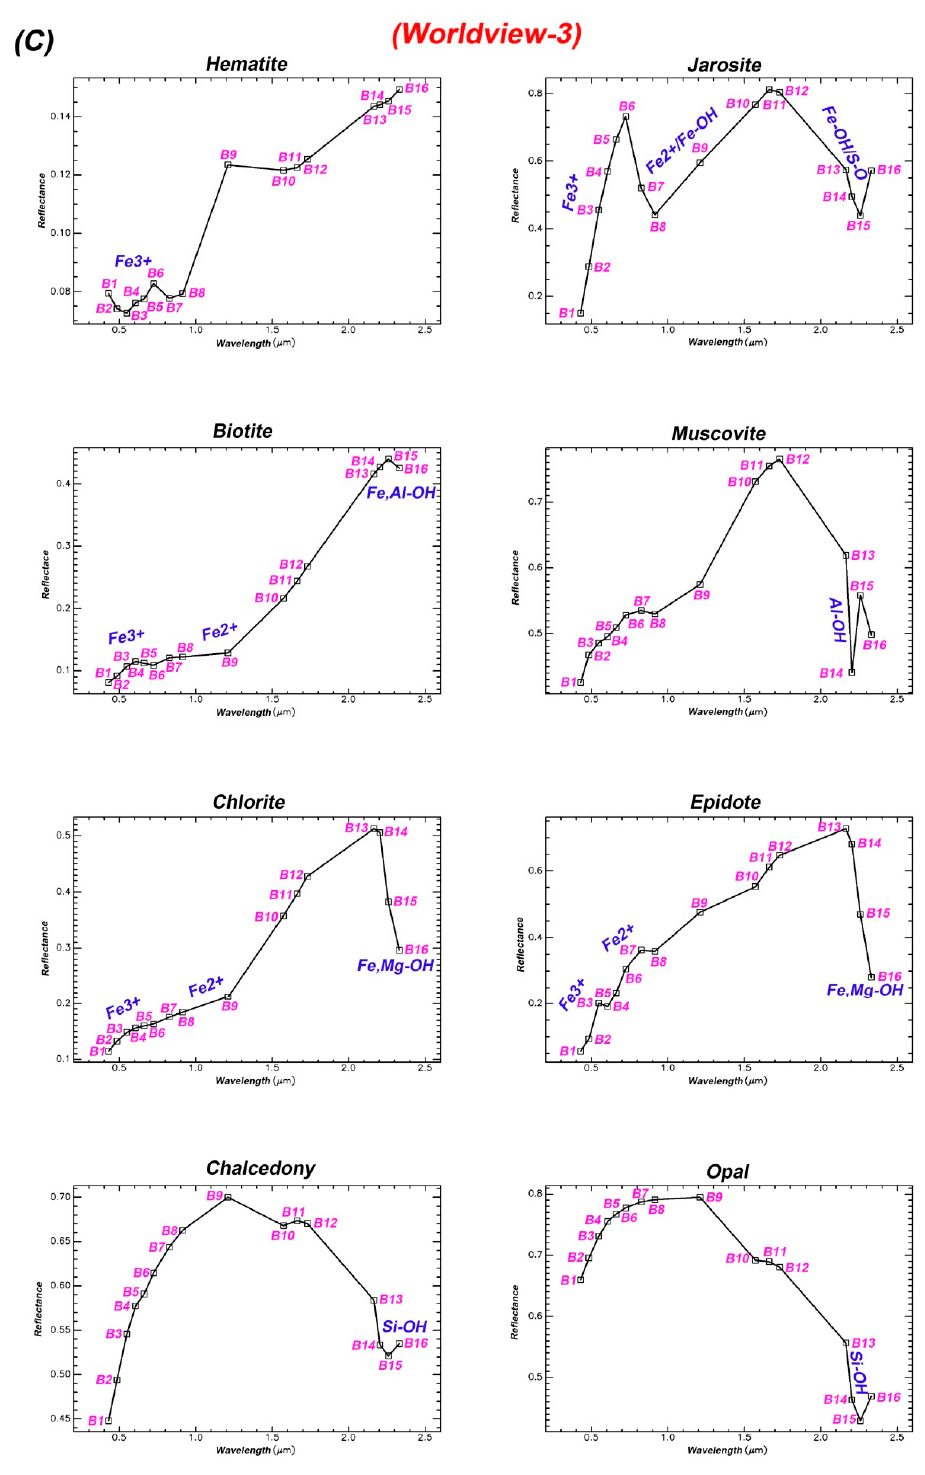
Figure 3. Laboratory reflectance spectra of hematite, jarosite, biotite, muscovite, chlorite, epidote, chalcedony (hydrous-silica), and opal (hyalite) resampled to response functions of VINR + SWIR bands of Landsat-8 ( A ), ASTER ( B ), and WV-3 ( C ) that were extracted from the USGS spectral library version 7.0 [75]. Cubes indicate the position of the VINR + SWIR bands of Landsat-8, ASTER, and WV-3 in the range of 0.4 μ m to 2.5 μ m.